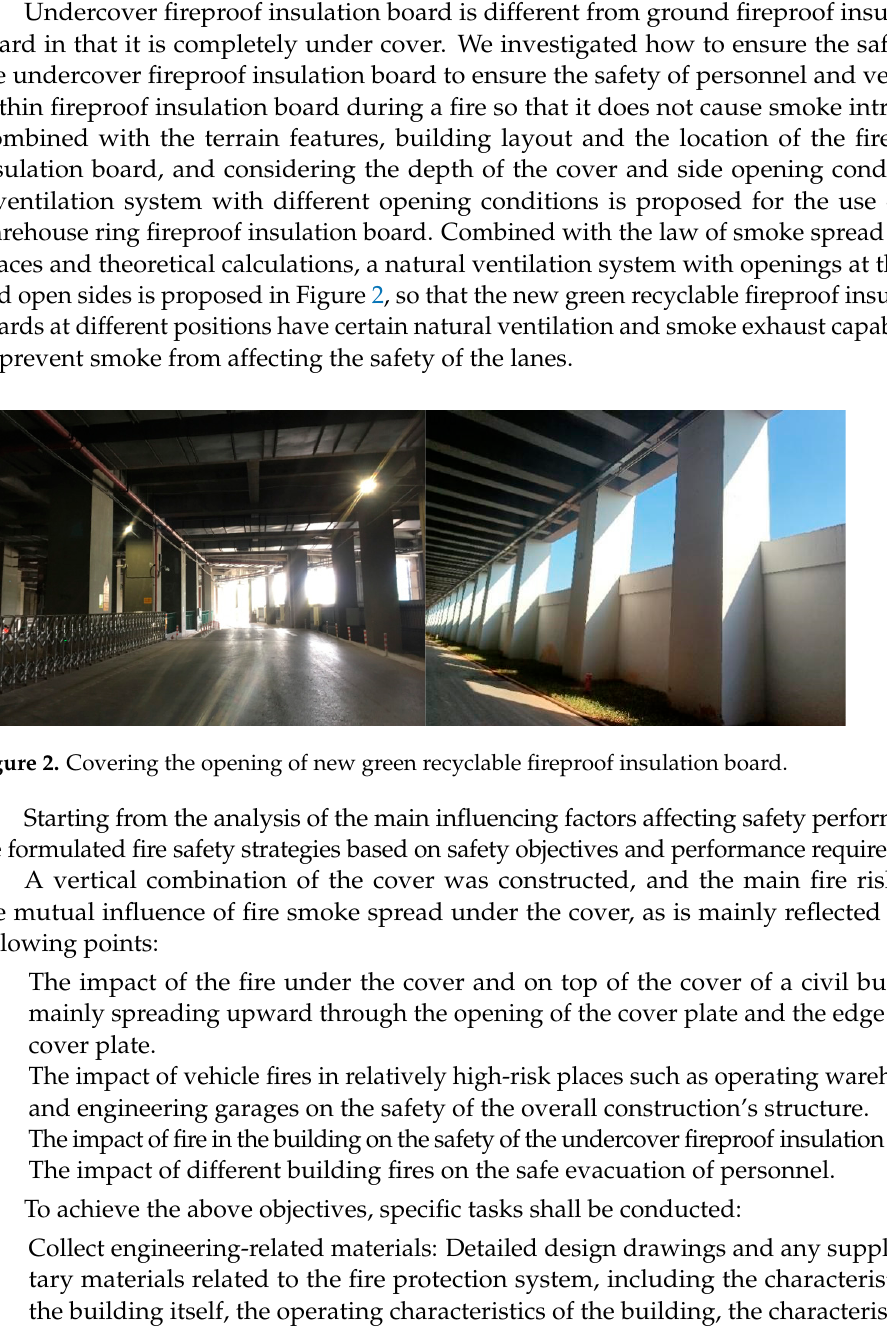
Figure 1. The process of recycling textile waste into ecological panels.